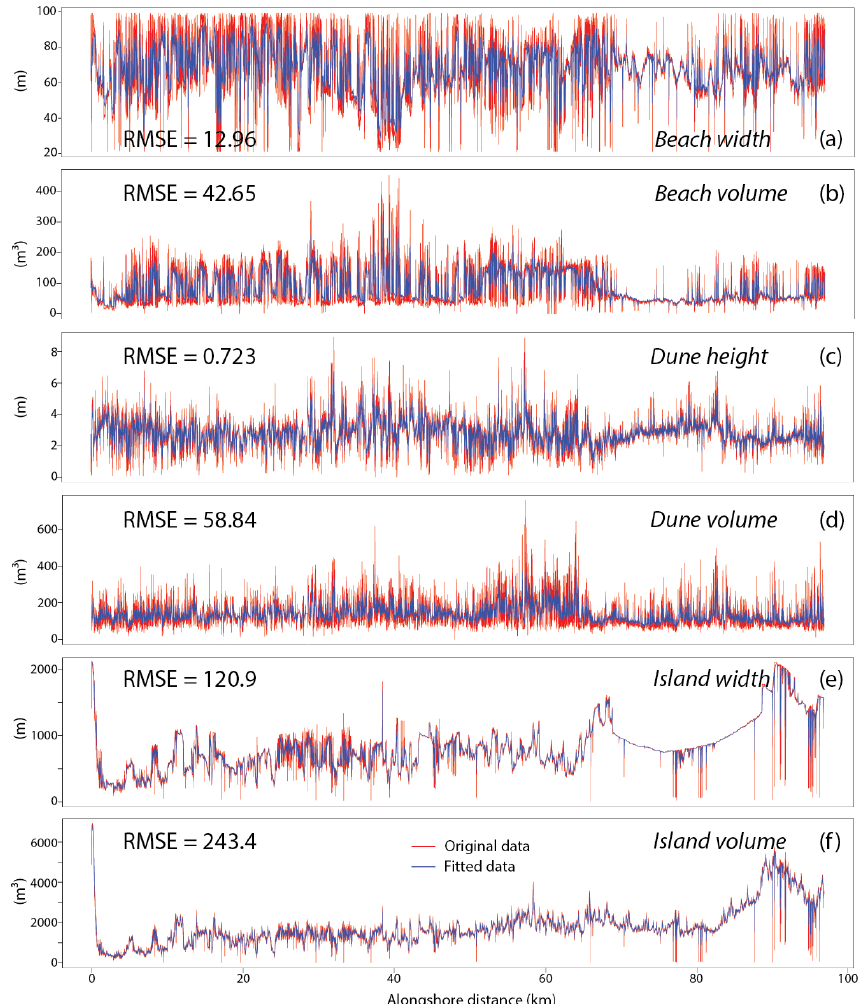
Figure 7. Example of the best fit ARIMA (0 d 0) models for each lidar-derived DEM metric: (a) beach width, (b) beach volume, (c) dune height, (d) dune volume, (e) island width, and (f) island